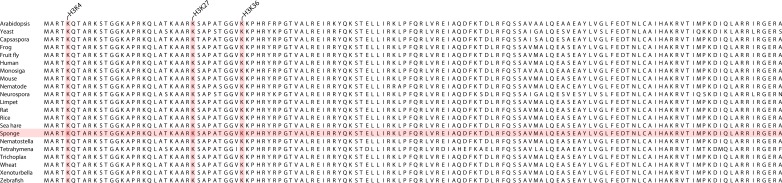
Multiple sequence alignment of various eukaryotic histone H3 proteins (1–136 amino acids), produced by using ClustalO (RRID:SCR_001591) (Sievers et al., 2011).Note that the entire amino acid sequence of histone H3 is highly conserved across eukaryotes. Sponge sequence is highlighted. The amino acid sequences used to generate the alignment are also provided in Figure 1—source data 2.